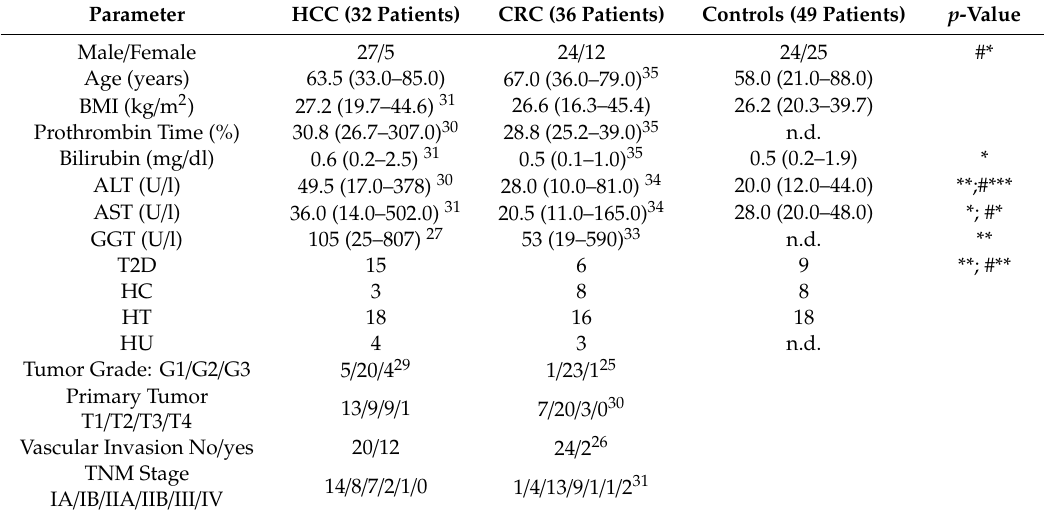
Table 1. Characteristics of the study